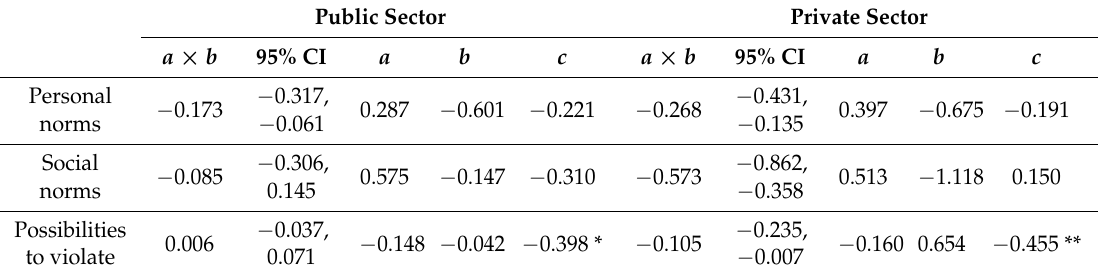
Table 5. Results of the mediation analyses for the public sector ( n = 234) and private sector ( n =